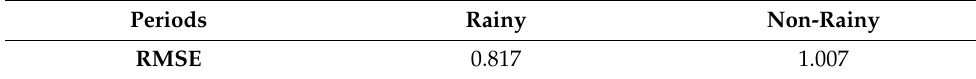
Figure 4. RMSEs of Scheme 4 during rainy and non-rainy phases in the period studied. Table 5. RMSEs (g/m 3 ) of Scheme 4 during rainy and non-rainy periods. Periods Rainy Non-Rainy RMSE 0.817 1.007